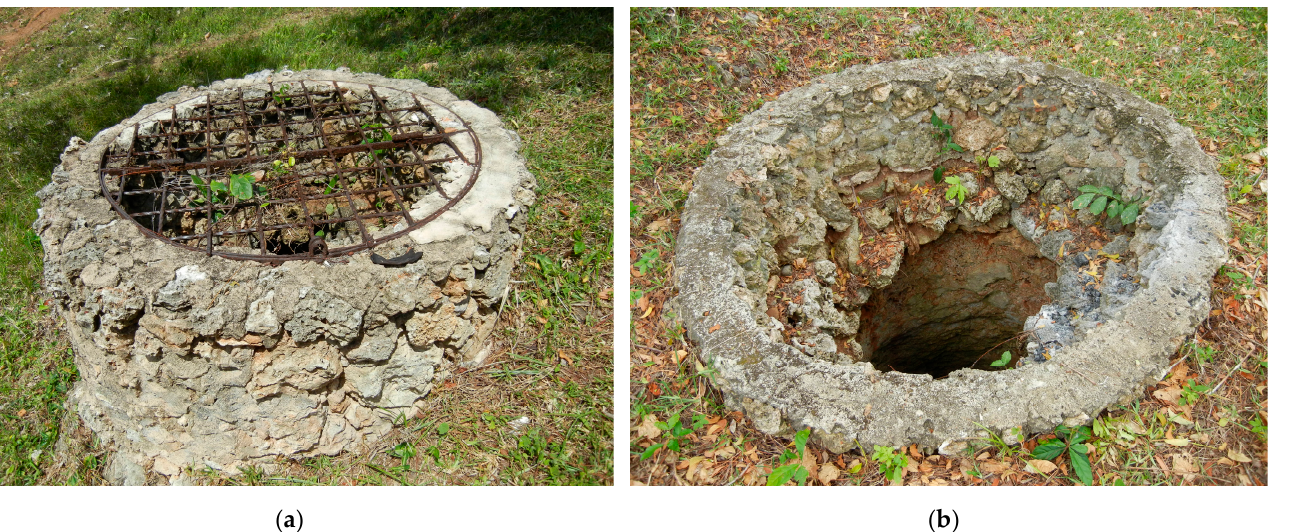
( b ) Figure 5. Examples of water containers from the precolonial town of Jumba la Mtwana. ( a ) A de- pression with the remainder of an inset water jar in the court of the largest house in the town, known as ‘House of Many Doors’, photo by the author, 2021; ( b ) A cistern in the so-called ‘House of the Cylinders’, which received its name after the two cylindrical seats, 3D scan processed by the Zamani 2021.